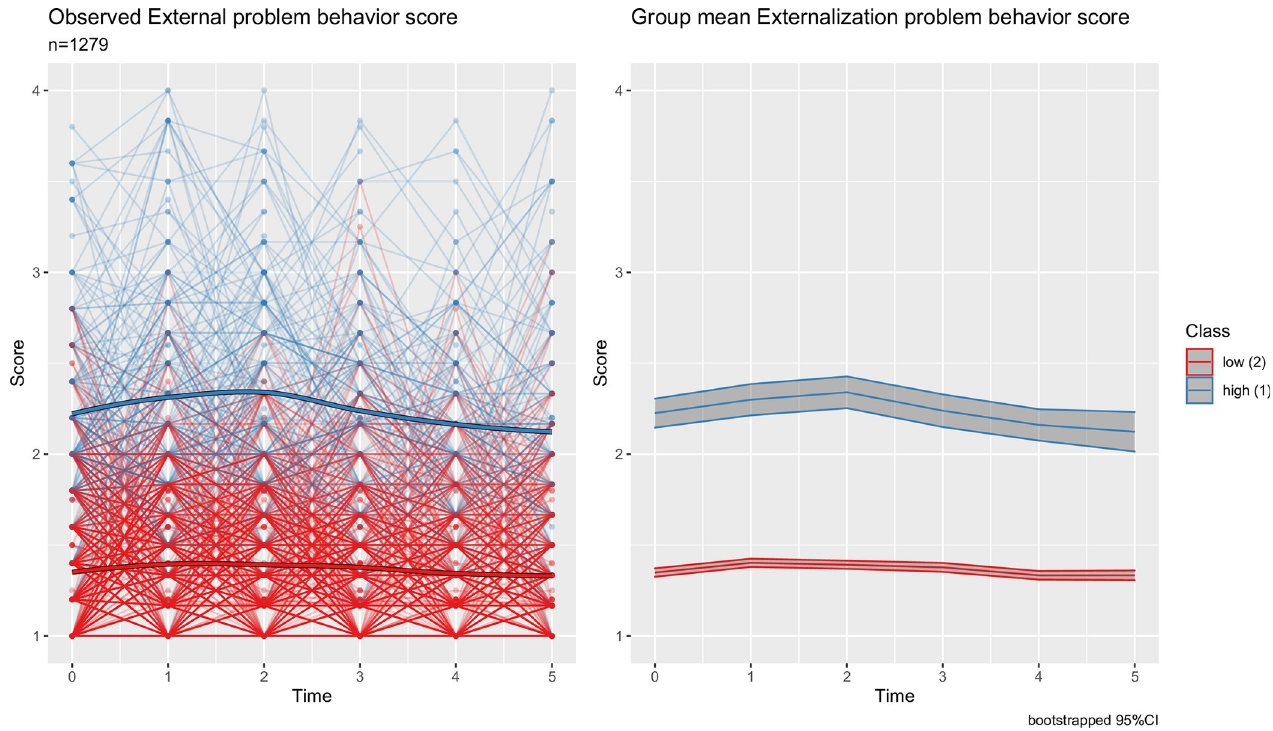
Fig 1. Longitudinal trajectories of externalizing problem behavior scoresLeft panel shows individual observed trajectories with dark line representing the mean for each latent class. Right panel shows class mean with shaded region representing the bootstrapped 95% confidence band.